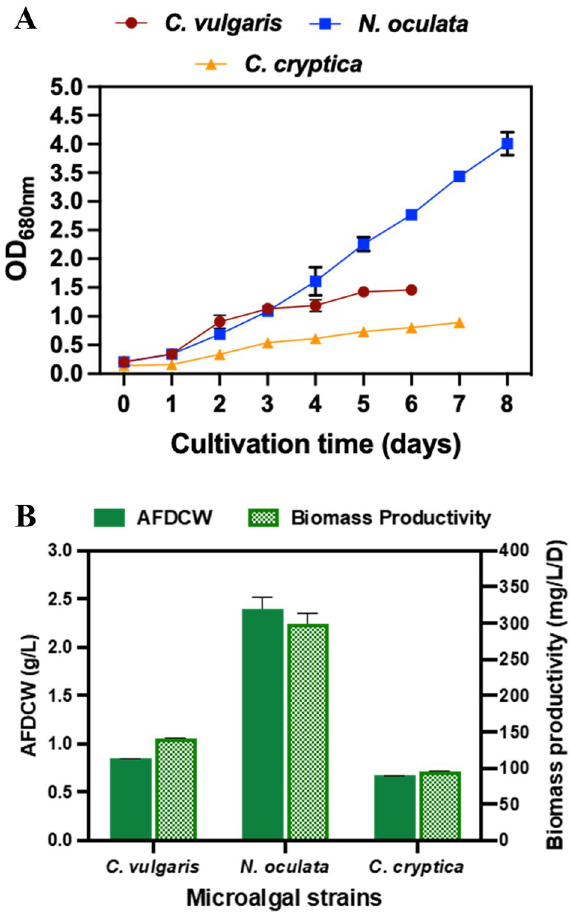
Figure 1. ( A ) Growth curve (O.D. 680 nm ); and ( B ) Ash-free dry cell weight (AFDCW; g/L) and biomass productivity (mg/L d) of C. vulgaris , N. oculata , and C. cryptica cultivated in